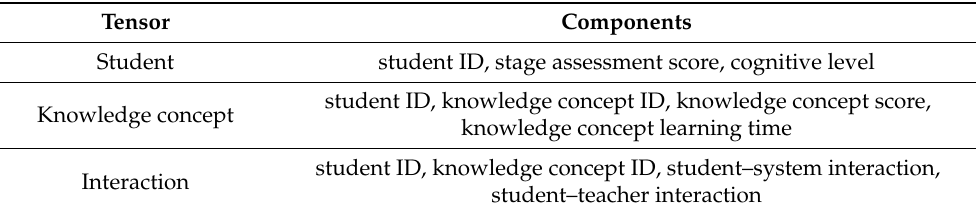
Table 2. Components of each order of the base